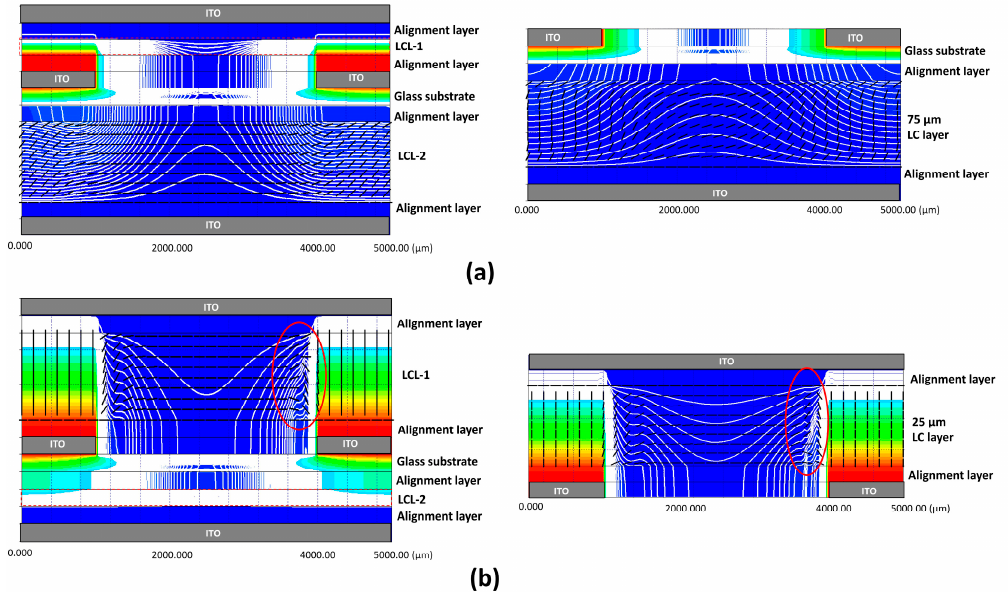
Figure 5. Comparison of the electrical equipotential line distribution in TLCL and conventional lenses via simulation at the same voltages: ( a ) Only considering LCs filled in the LCL-2 layer with a thickness of 75 μ m; ( b ) Only considering LCs filled in the LCL-1 layer with a thickness of 25 μ m. The areas marked with closed red curves indicate the occurrence of disclination lines.